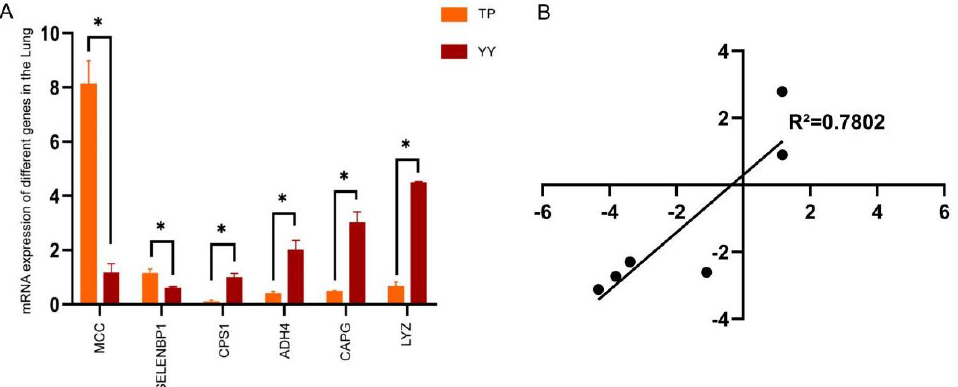
Figure 3. Validation of the RNA-Seq approach using RT-qPCR ( A ); transcriptome confirmation using real-time RT-qPCR [results represent means ± S.E.M.] ( B ); log2 fold changes in gene expression for RT-qPCR and RNA-Seq data, which are closely correlated (R = 0.7802; p = 0.0196), confirming the accuracy of the RNA-seq approach. * p < 0.05.